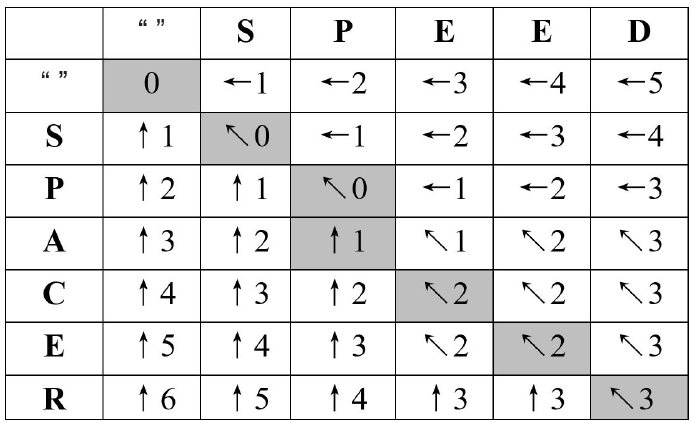
Figure 2. An example of Levenshtein/edit distance table for input sequences “SPACER” and “SPEED” . The path that yields the edit distance is highlighted to trace back the required operations. Here, ← denotes “insertion” operation, ↑ denotes “deletion” operation, and (cid:45) denotes “substitution” operation if A i (cid:54) = B j .